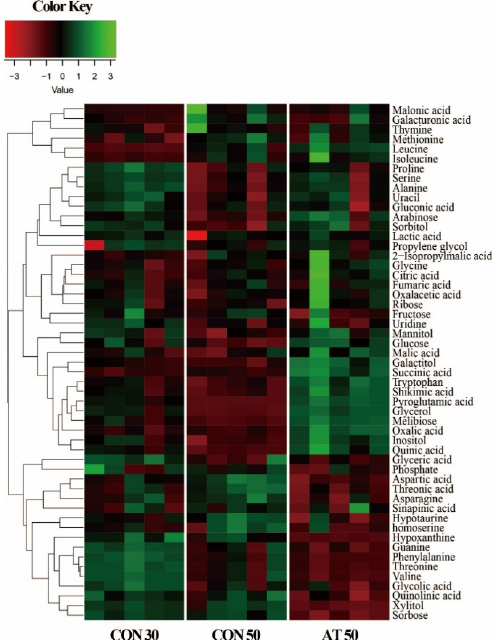
Figure 2. A heatmap showing metabolite differences between the control groups (CON30 and CON50) and the ampicillin-treated group (AT50). CON30 and CON50 refer to the control group on the 30th and 50th day of fermentation, respectively. AT50 refers to the ampicillin-treatment group on the 50th day of fermentation.